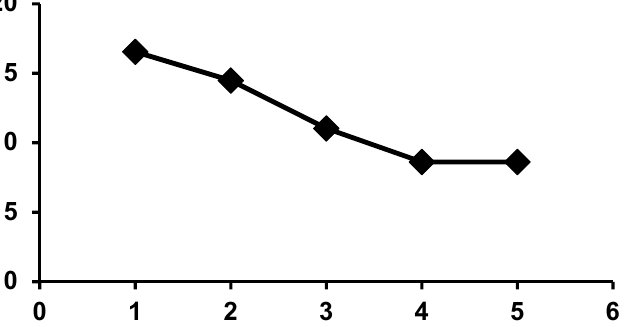
Figure 3. Amount of PMo 12 remaining on the sample (in wt %, Y-axis) as a function of the number of washing steps (X-axis). Adapted from [13].